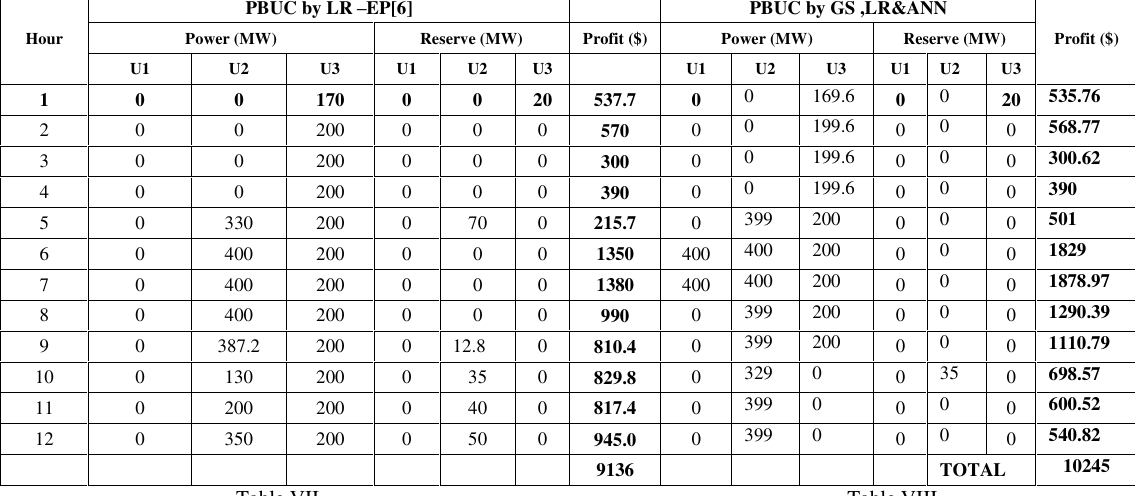
Table VIII Comparison of the results of 3 unit system with